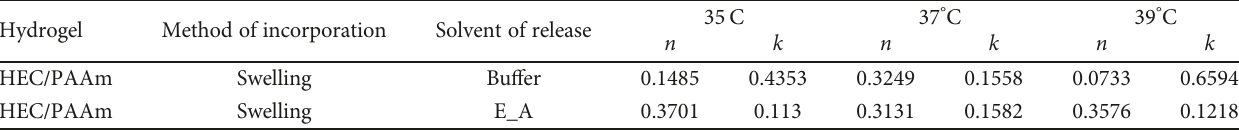
Table 1: Values of n calculated for the kinetics of ASA release from xerogels.